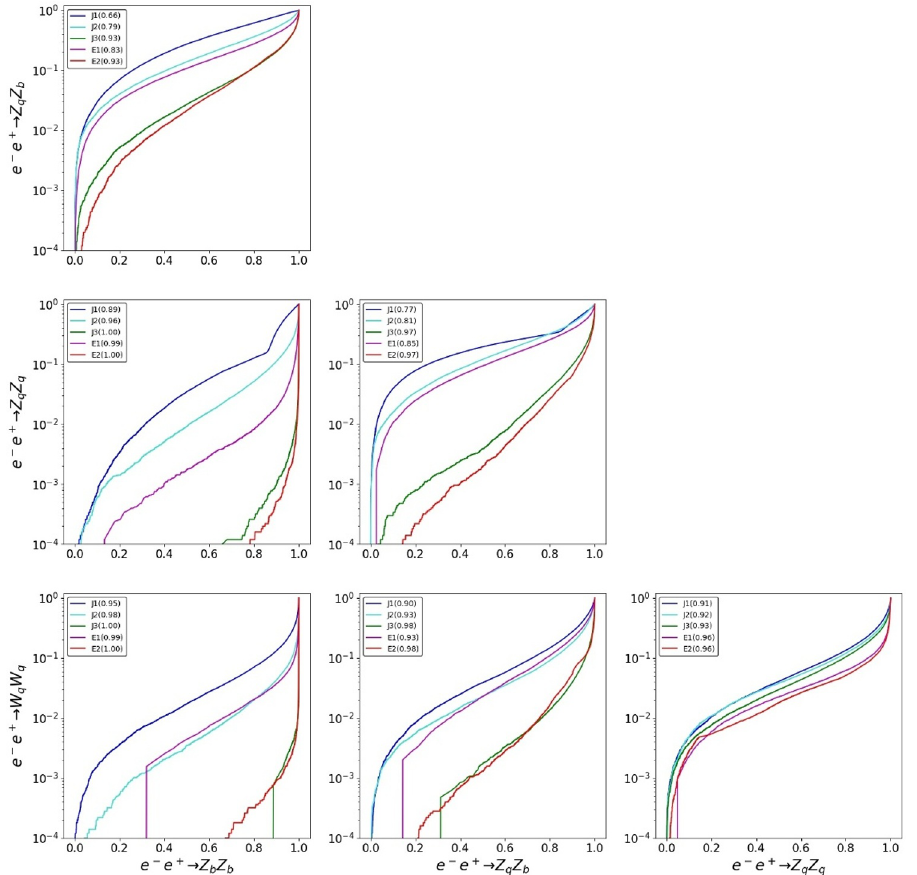
Figure 13 . ROC curves and their AUC for the binary classi(cid:12)ers to distinguish between the four classes of four-jet